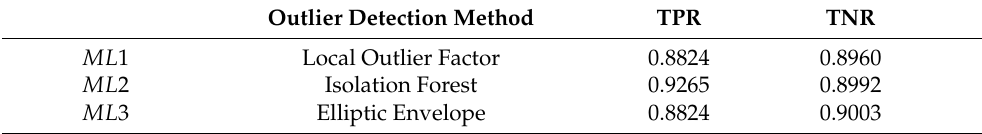
Table 2. Performance of the selected outlier detection methods